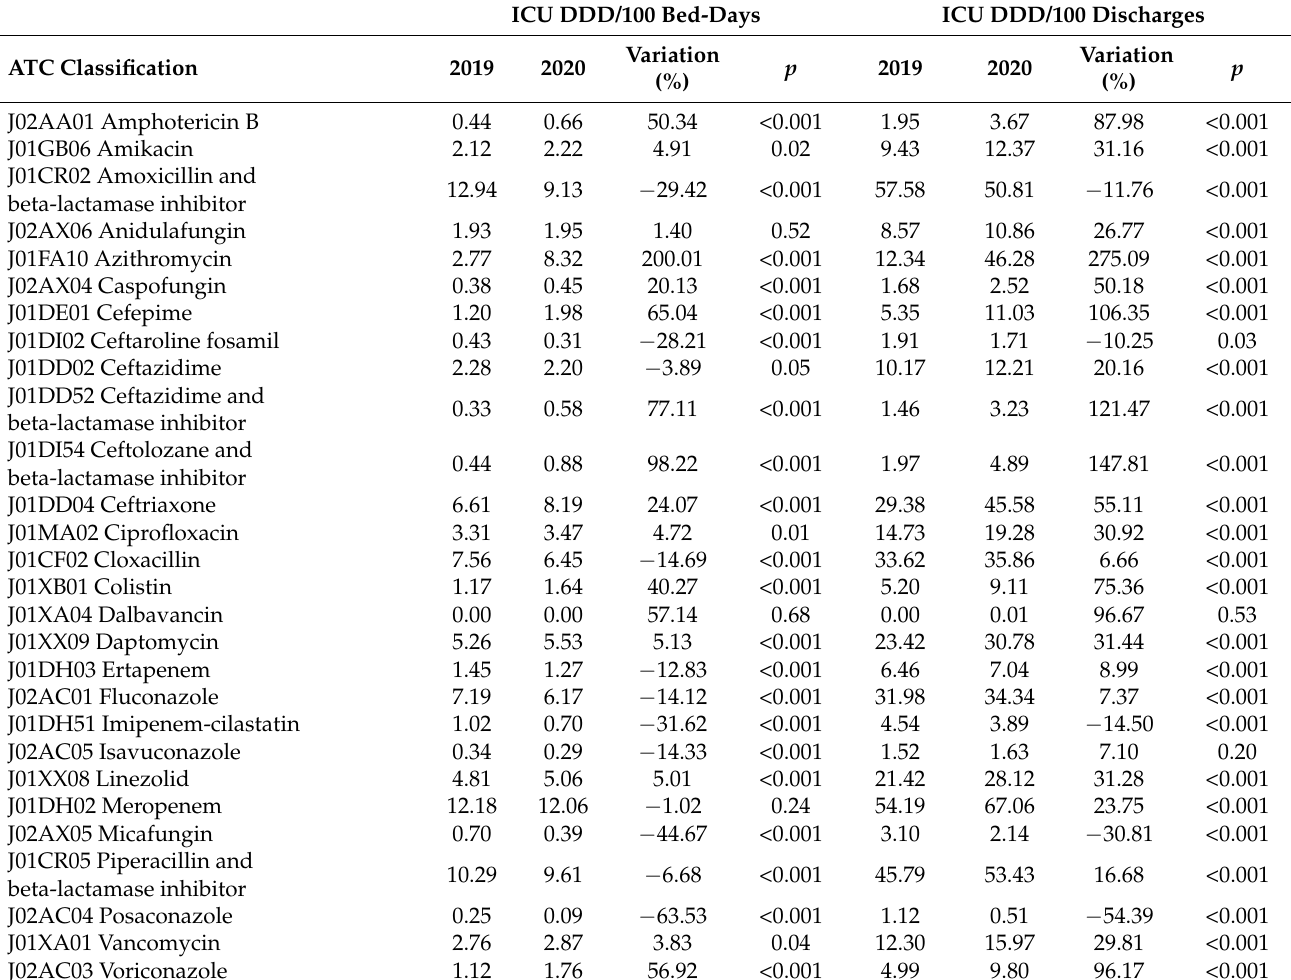
Table 2. Changes in intensive care unit (ICU) consumption of major anti-infectives for systemic use